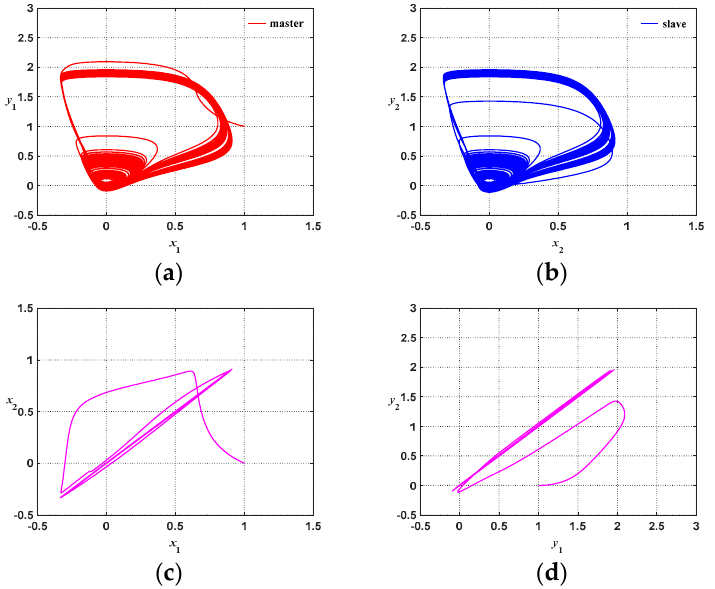
Figure 11. Uncontrolled coupled nonlinear chaotic system ( g = 1): ( a ) Master system phase diagram; ( b ) Slave system phase diagram; ( c ) x 1 , x 2 phase diagram; ( d ) y 1 , y 2 phase diagram.